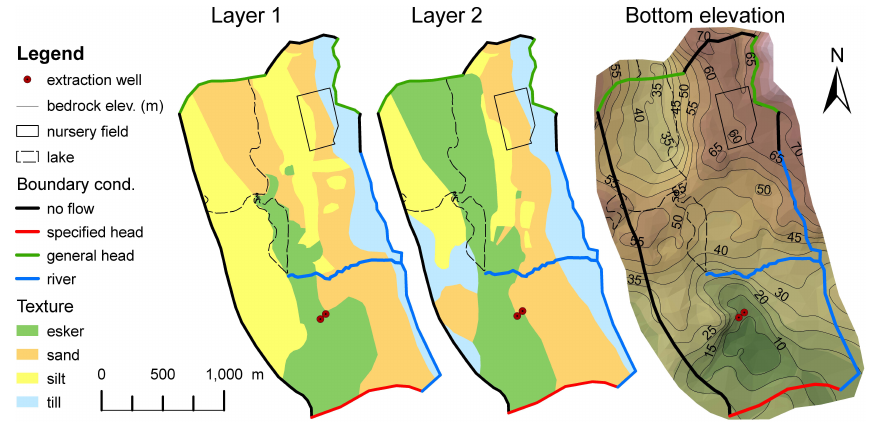
Fig. 10. Boundary conditions of the groundwater flow model. The model consisted of two layers, which were divided into four texture groups with various hydraulic conductivities. The calibrated conductivities were as follows: 25 to 200md − 1 for esker material, 2.0 to 20md − 1 for sand, 0.0004 to 1.0md − 1 for silt and 0.20 to 4.0md − 1 for till. The modeled bottom elevation consisted mainly of the bedrock, but surfaces of silt or clay were found in some locations underlying more coarse-grained